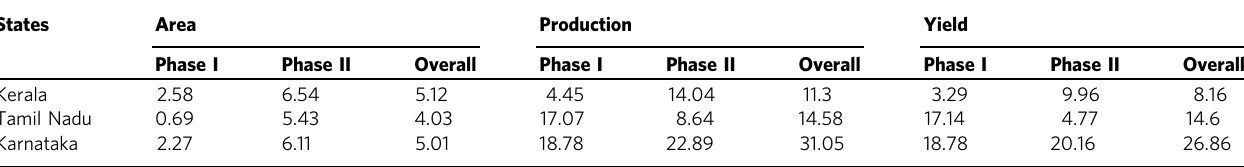
Table 4 Instability index of coconut in